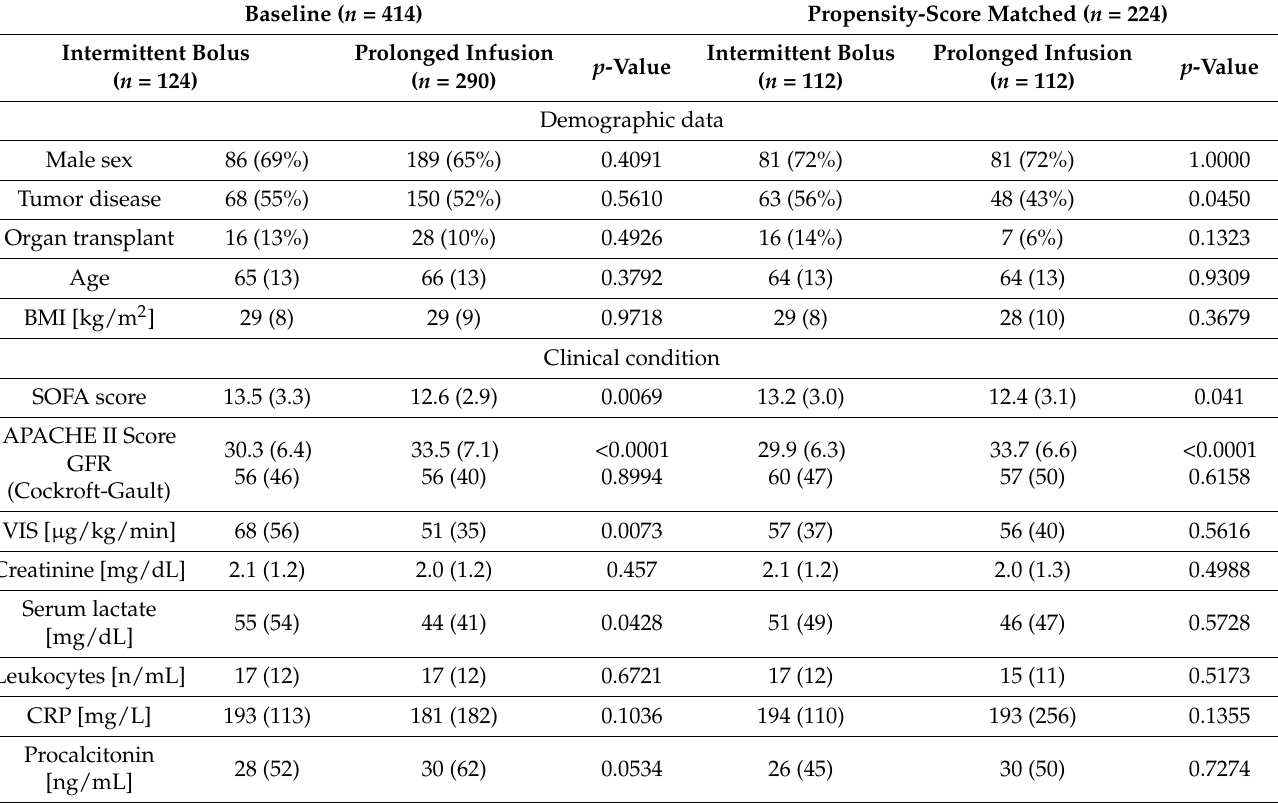
Table 1. Patient characteristics at study enrollment (onset of septic shock*) in baseline cohort and propensity-score analysis. Baseline ( n = 414) Propensity-Score Matched ( n =